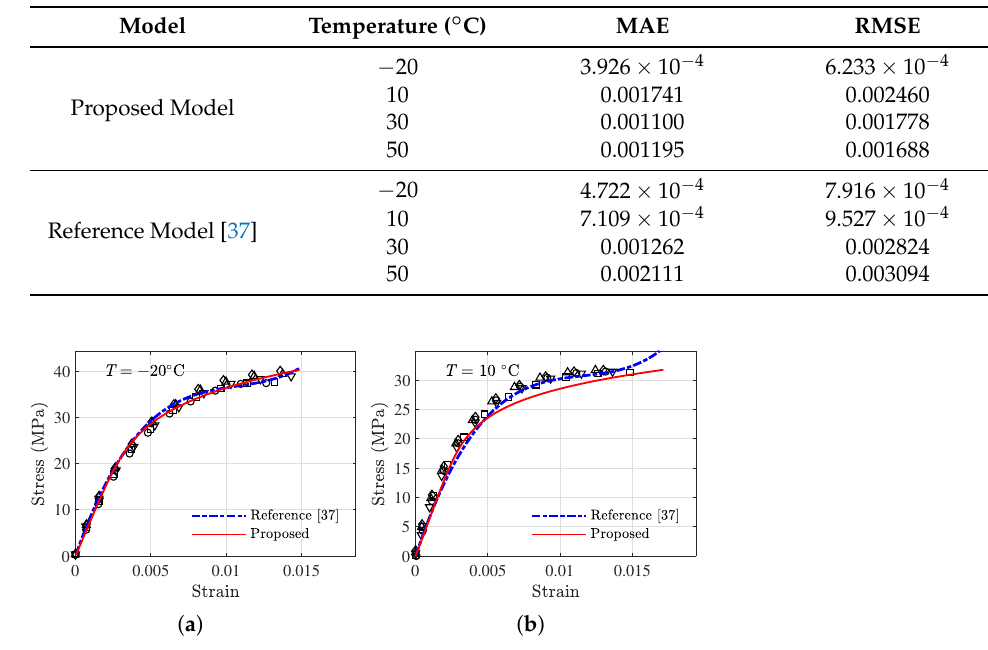
Table 5. Comparisons of the performance between the proposed model and reference model for compression data.